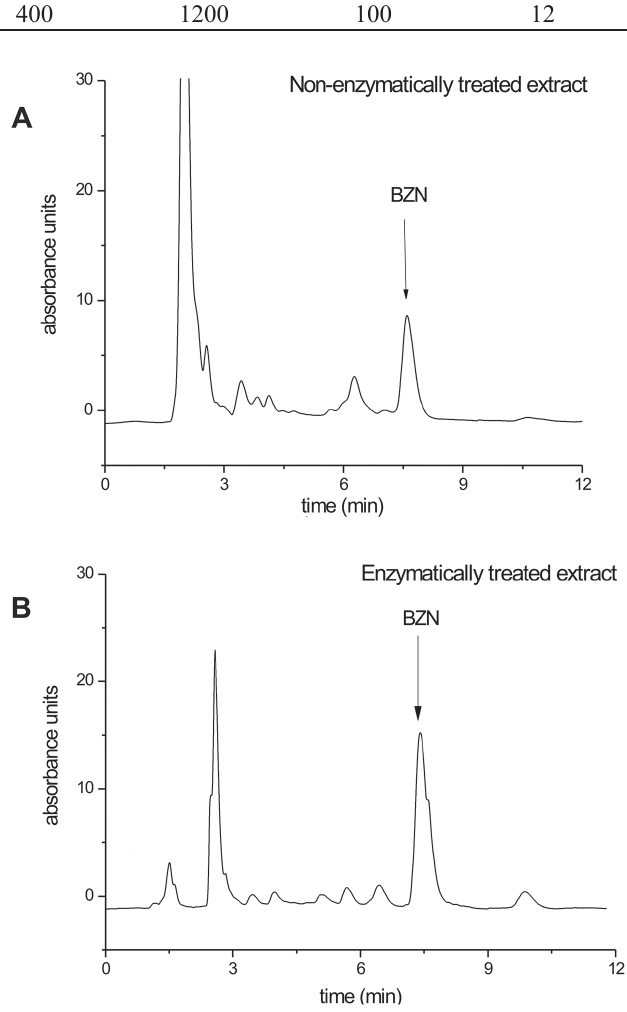
FIGURE 1 - Qualitative comparison of chromatographic profiles: A Example of a non-enzymatically treated urine extract chromatogram. B Example of an enzymatically treated urine extract